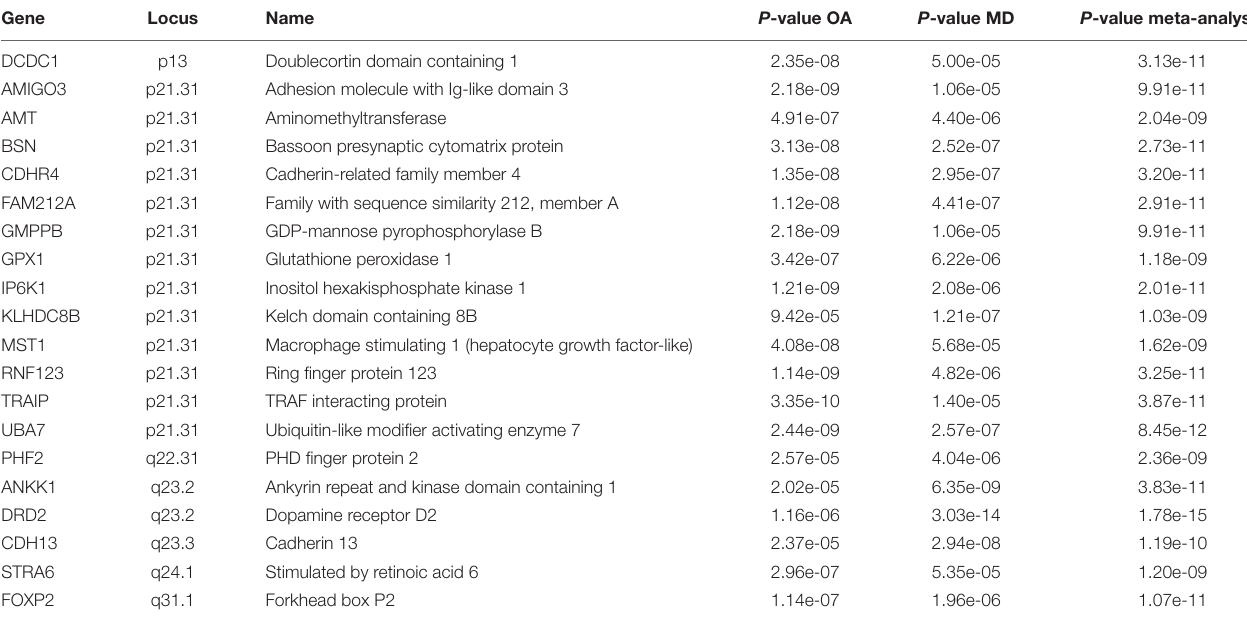
TABLE 2 | List of top 20 pleiotropic OA/MD risk genes.